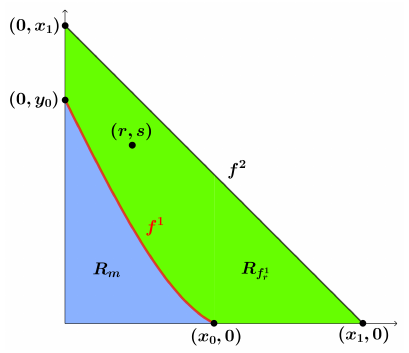
Figure 4. Frozen ( R f 1